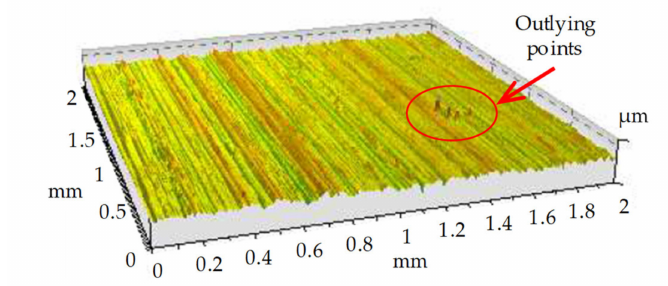
Figure 10. Outliers on the ground surface (procedure version